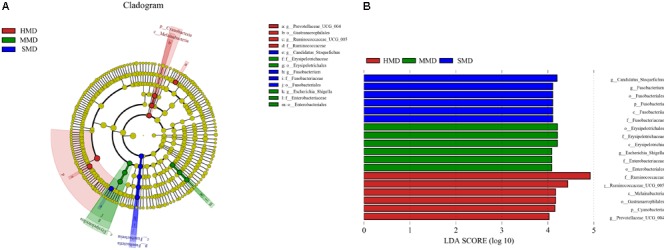
LefSe analysis. (A) The cladogram diagram shows the microbial species with significant differences in the three groups. Red, green, and blue indicate different groups, with the species classification at the level of phylum, class, order, family, and genus shown from the inside to the outside. The red, green, and blue nodes in the phylogenetic tree represent microbial species that play an important role in the HMD, MMD, and SMD groups, respectively. Yellow nodes represent species with no significant difference. (B) Species with significant difference that have an LDA score greater than the estimated value; the default score is 4.0. The length of the histogram represents the LDA score; i.e., the degree of influence of species with significant difference between different groups.